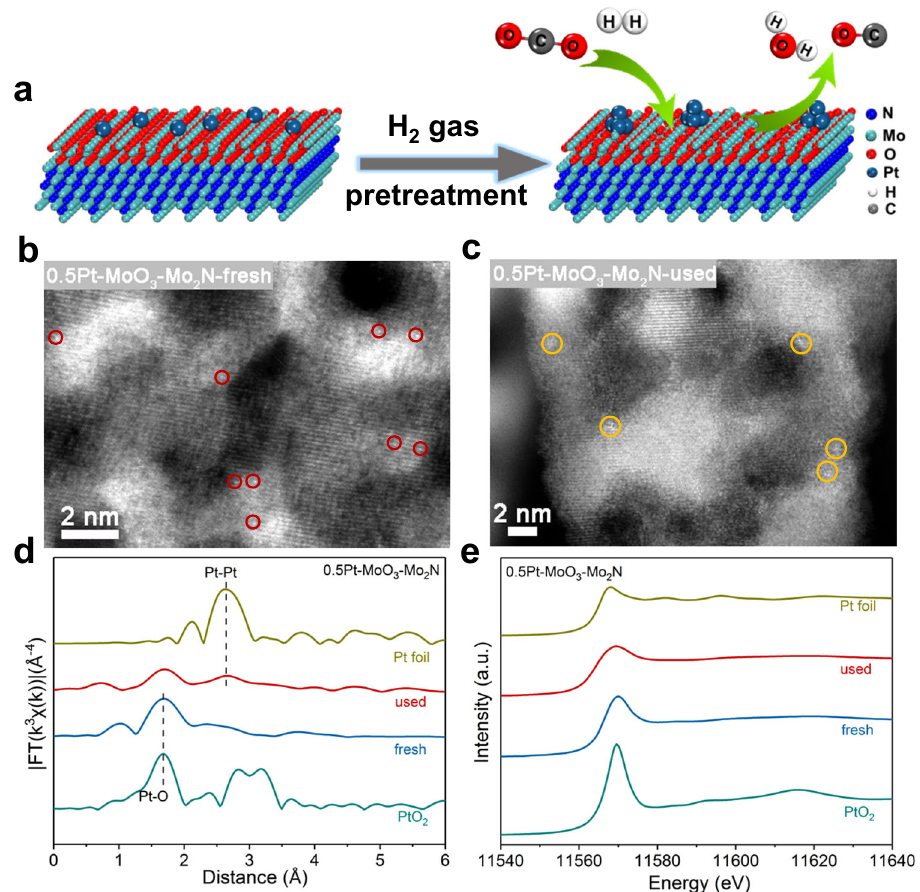
Fig.1|Structuralcharacterizationof0.5Pt – MoO 3 /Mo 2 N.a Schematicillustration of the catalyst structure. b , c Aberration-corrected HAADF-STEM images of fresh